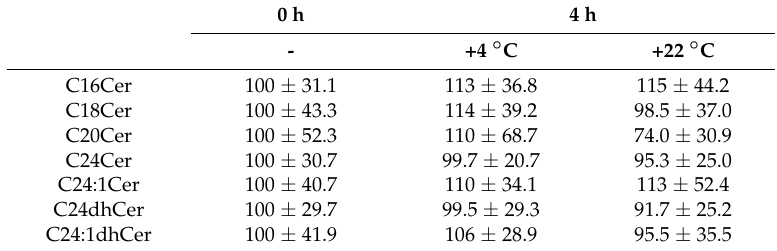
Table 4. Temperature-dependent effect on relative sphingolipid levels in freshly isolated human